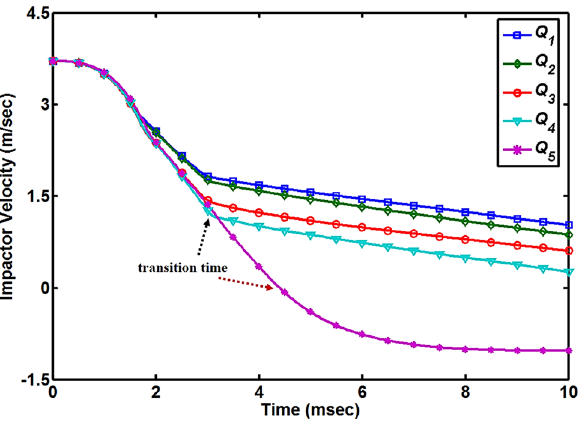
Figure 4. Impactor velocity versus time diagram for all quasi-isotropic composite